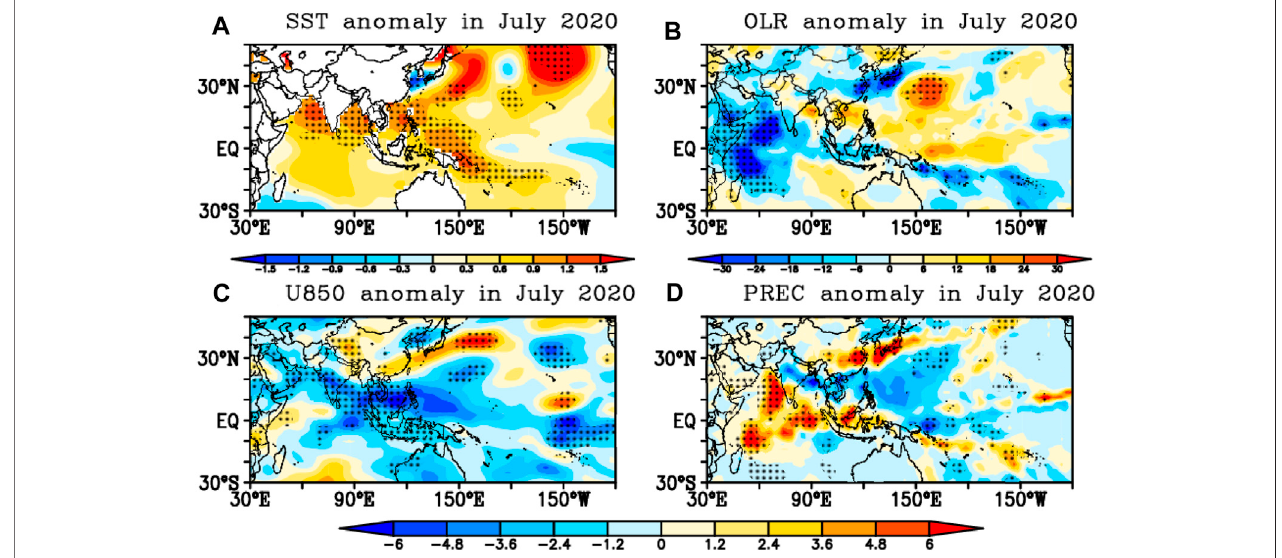
FIGURE6| The (A) SSTanomaly (units: K), (B) OLR (units: W/m 2 ), (C) 850-hPazonalwindanomaly (units: m/s),and (D) precipitationanomaly (units: mm/day)in July 2020. Dotted areas indicate that the value in July 2020 is the highest or lowest of the values in July 1980 – 2020.